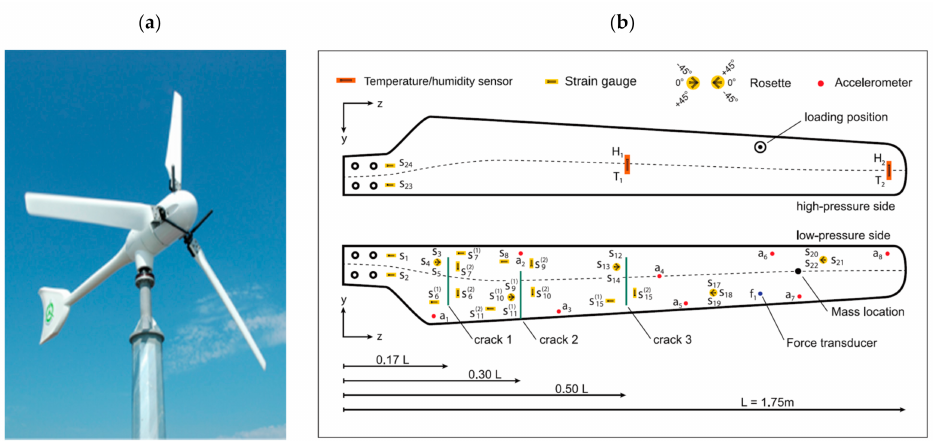
Figure 4. Sonkyo Windspot 3.5 kW: ( a ) the turbine and ( b ) the sensor locations in the blade